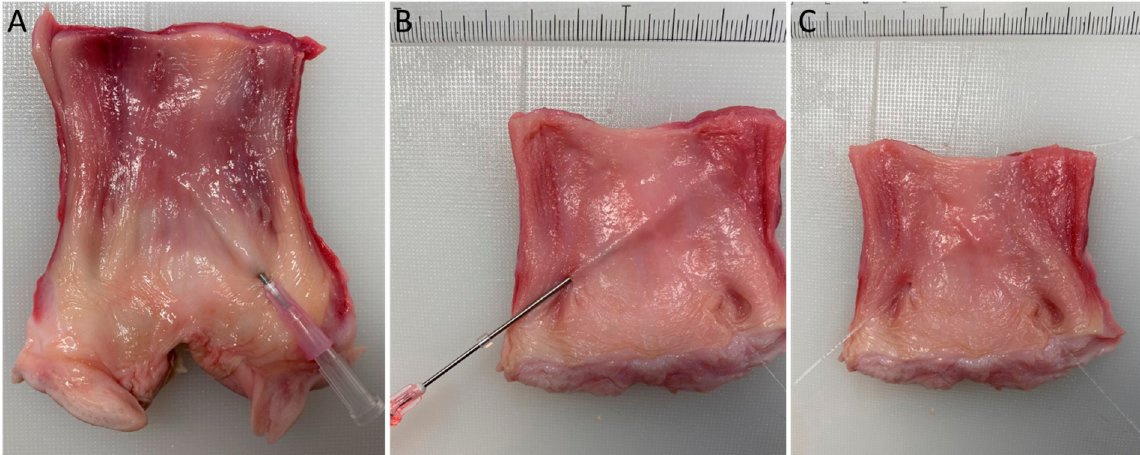
Figure 3. ( A ) Vaginal wall specimen with a needle (procedure beginning); ( B ) Vaginal wall specimen with an inserted cannula and cog thread (intersecting under 90° angle). ( C ) Vaginal wall specimen with 2 crossed cog threads.